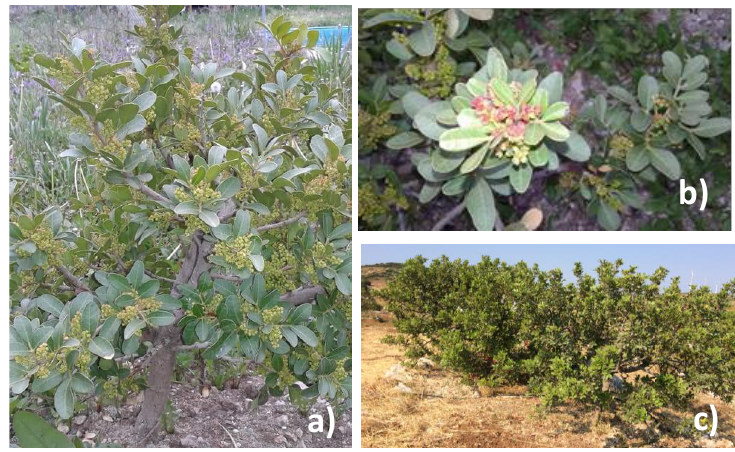
Figure 2. Cultivated mastic trees in Mordogan, Karaburun Peninsula, ( a and b ) and Nezih Ozture Farm, Cesme Peninsula ( c ). Photos courtesy of Mustafa Ozer ( a and b ) and A.N. ( c ).